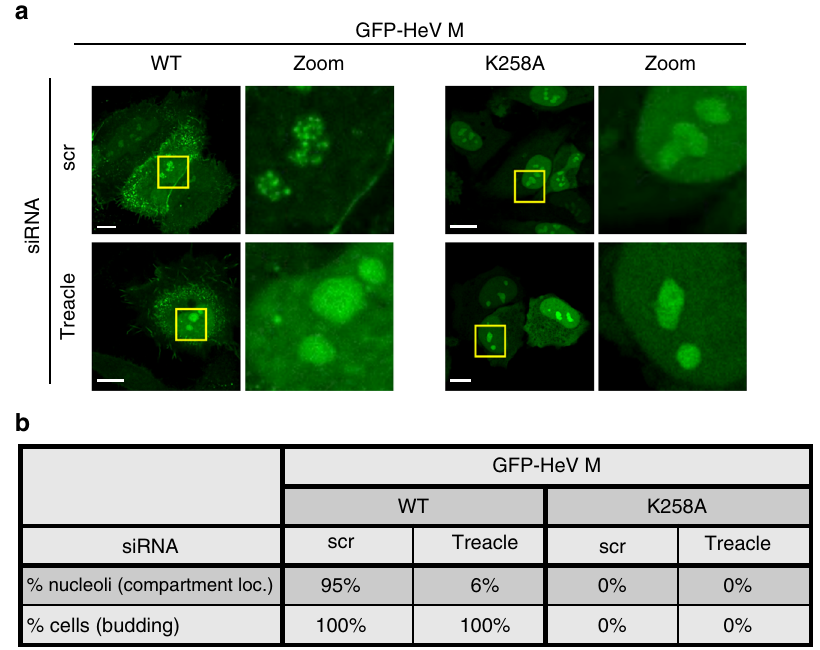
Fig. 4 Subnucleolar compartment localization, but not budding function of M protein, is dependent on Treacle. a HeLa cells were transfected with scr siRNA or Treacle siRNA two days prior to transfection to express the indicated GFP-HeV M proteins, and imaging of living cells 16 h later. Representative images are shown for each condition; yellow boxes highlight regions of images magni fi ed in the Zoom panel. Scale bars correspond to 15 μ m. b Images such as those in a were used to calculate the percentage of nucleoli with subnucleolar compartment localization (% nucleoli — compartment loc.; analysis of ≥ 99 nucleoli for each condition from three independent experiments) and percentage of cells with ‘ budding ’ phenotype, as described in legend to Fig. 2 (% cells — budding; ≥ 91 cells analyzed per sample from three independent